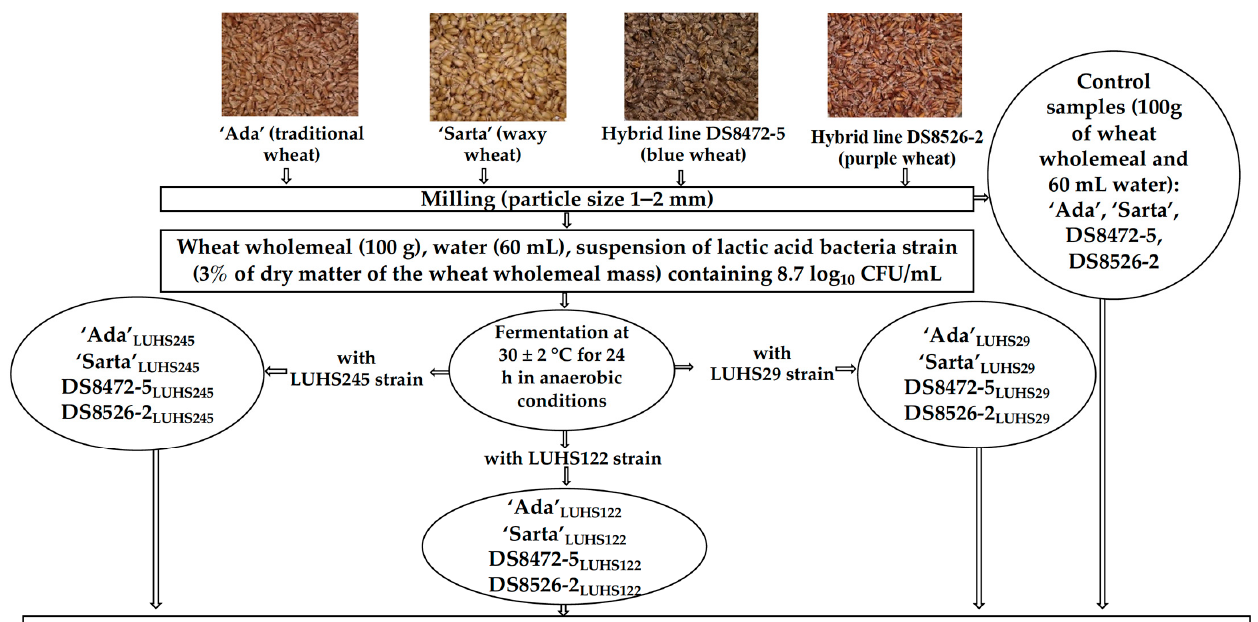
Figure 1. The principal scheme of the experiment ( Pediococcus acidilactici LUHS29, Liquorilactobacillus uvarum —LUHS245, and Lactiplantibacillus